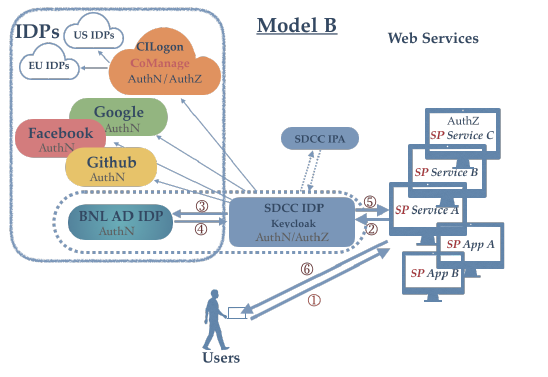
Figure 4. Federation using Keycloak’s identity brokering capability.